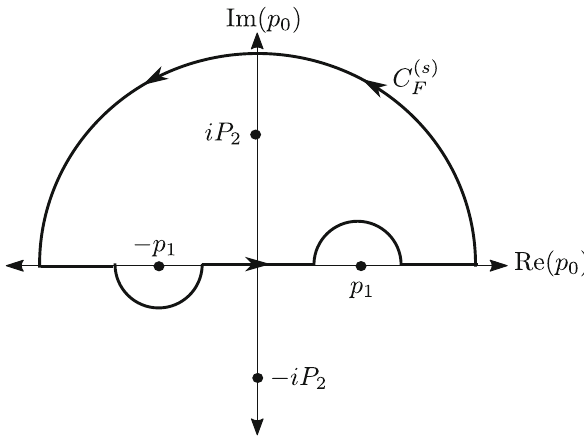
Fig. 1 The path of integration C ( s ) for the scalar propagator which F encloses the poles − p 1 and i P 2 when closing the contour upward and encloses the poles p 1 and − i P 2 when closing the contour downward